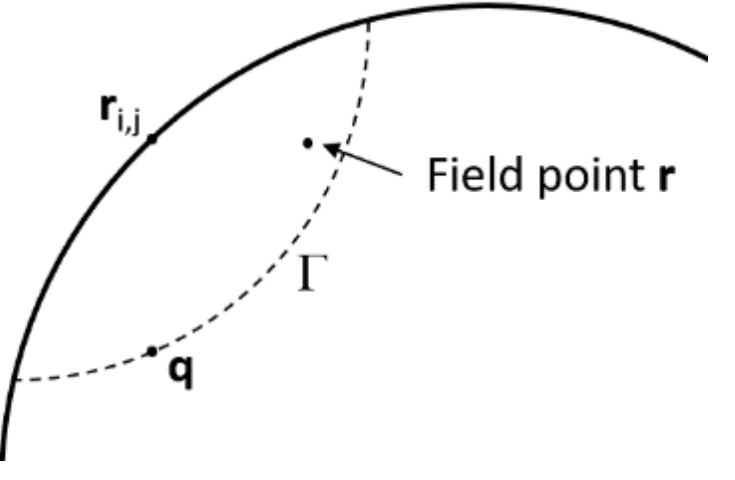
Figure 2. The matching interface Г .